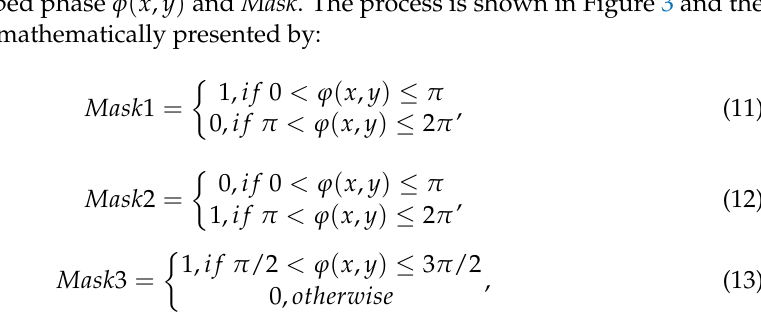
Figure 4. The process of decoding.